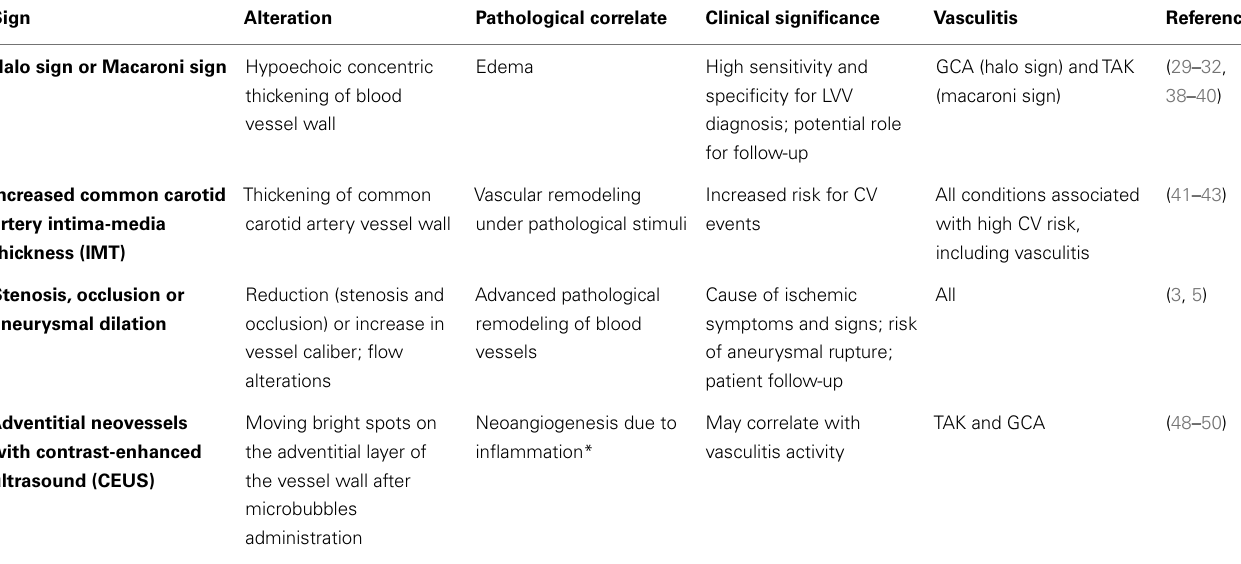
Table 2 | Summary of main ultrasonographic findings in inflamed blood vessel, together with their pathological correlate and clinical significance